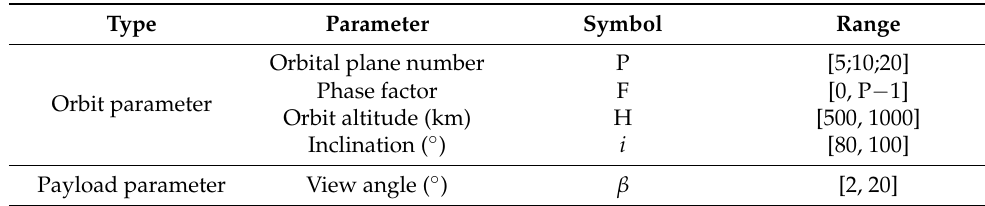
Table 1. The ranges of the parameters.